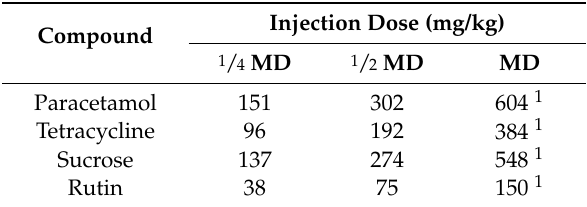
Table 3. Compound doses used for hepatotoxicity testing (pericardial injection).